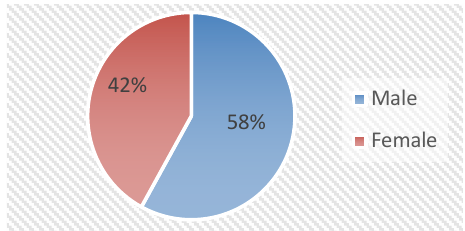
Figure 1: Gender of